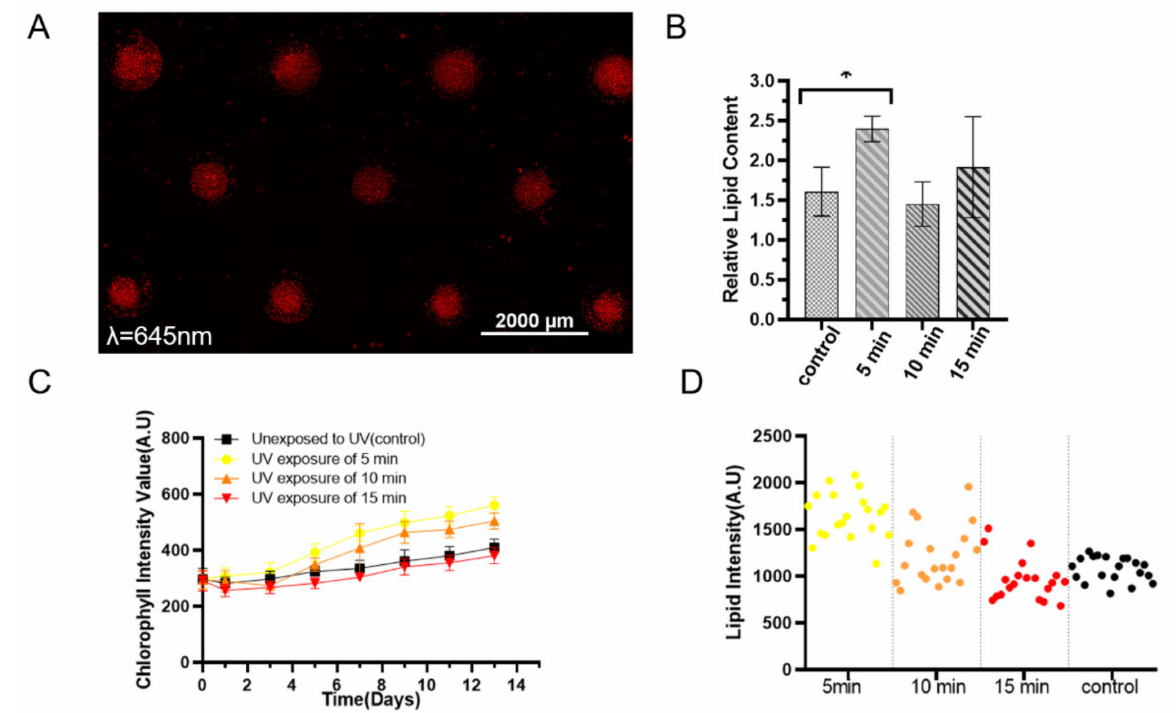
Figure 3. B. braunii treated with a UV mutagenesis procedure on a chip, and its lipid content comparison. ( A ) Representative images of algal cells in the chip observed at wavelength 645 nm on its fourteenth day of culture. ( B ) Quantification of lipid content of three UV-C exposures of a chip—5, 10 and 15 min, with unexposed chip as a control (* indicated p -value < 0.05, n = 60). ( C ) Comparison of growth curves of three UV-C chips with exposures 5,10 and 15 min with an unexposed chip as a control ( n = 60). ( D ) Scatter plot of the mean intensity of Nile-stained algal cells shows a variation in lipid production with different UV exposure ( n = 20 for each UV irradiance